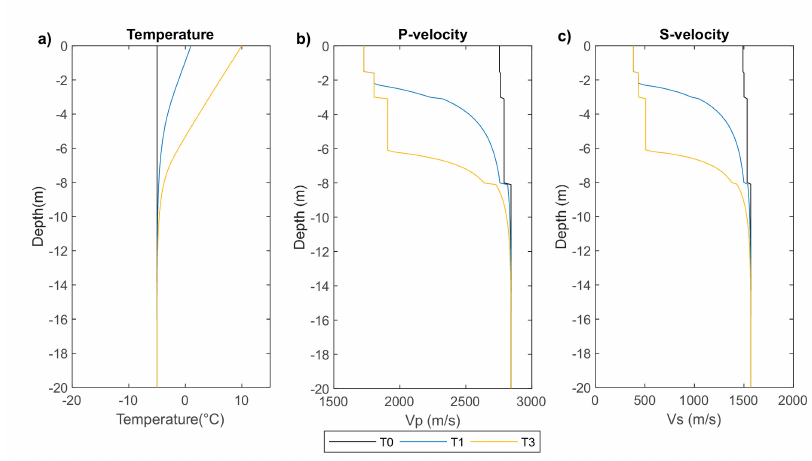
Figure 3. Variation in temperature and seismic velocities with depth for a specific point in time (after four years) for models T0 (initial model, − 5 ◦ C through the column), T1 (top boundary temperature = + 1 ◦ C), and T3 (top boundary temperature = + 10 ◦ C). ( a ) Temperature profiles, ( b ) P-wave velocity profiles, and ( c ) S-wave velocity profiles. Temperature is equal at all depths for T0, so the observed velocity variation with depth is only due to the porosity decrease: 40% in the upper layer, 35% in the second layer, 30% in the third layer, and 20% in the bottom